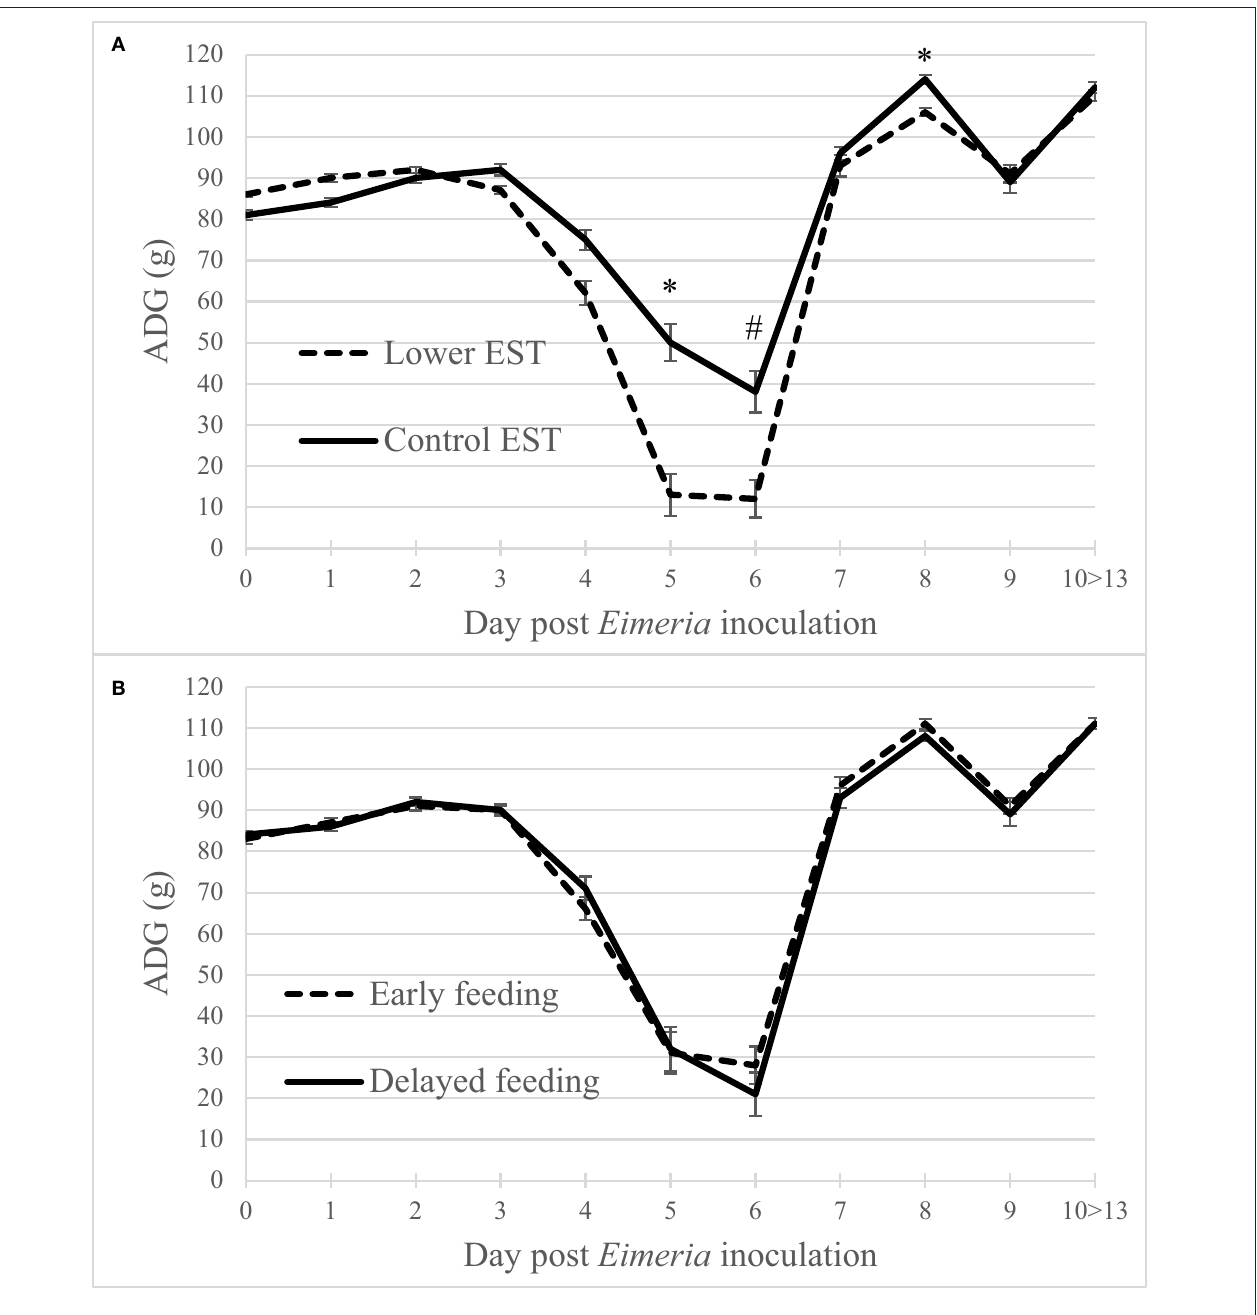
FIGURE 2 | (A) Effect of eggshell temperature ( EST ) during late incubation [ ≥ embryonic day 17–19.5; 37.8 ◦ C ( control ) or 36.7 ◦ C ( lower )] or (B) effect of feeding strategy after hatch [immediate access to feed and water ( early ) or 51–54-h deprivation ( delayed )] on broiler average daily gain during 13 days post Eimeria inoculation (d 21 post hatch) to induce necrotic enteritis ( N = 16 pens/treatment). An asterisk (*) indicate significant difference ( P < 0.05) between LSmeans of treatments within day post Eimeria inoculation and a hashtag ( # ) indicates s tendency to differ ( P < 0.10). Error bars indicate standard